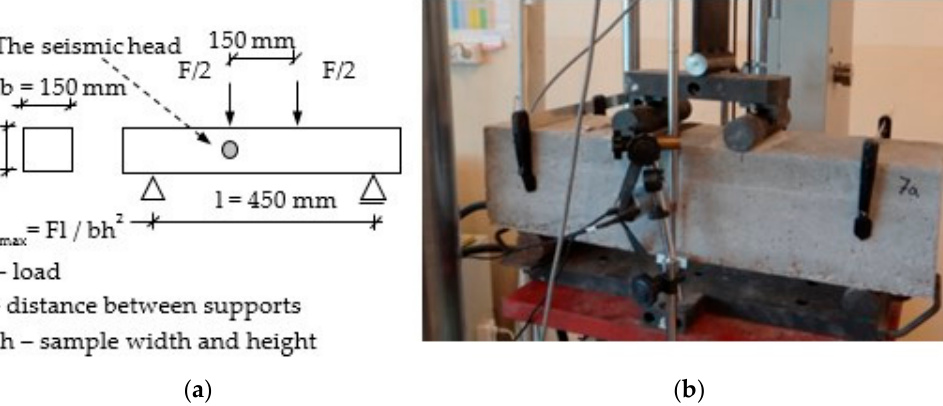
Figure 1. Four-point bending test: the specimen before the test in the test machine: ( a ) diagram of the test [44], ( b ) the specimen before test.